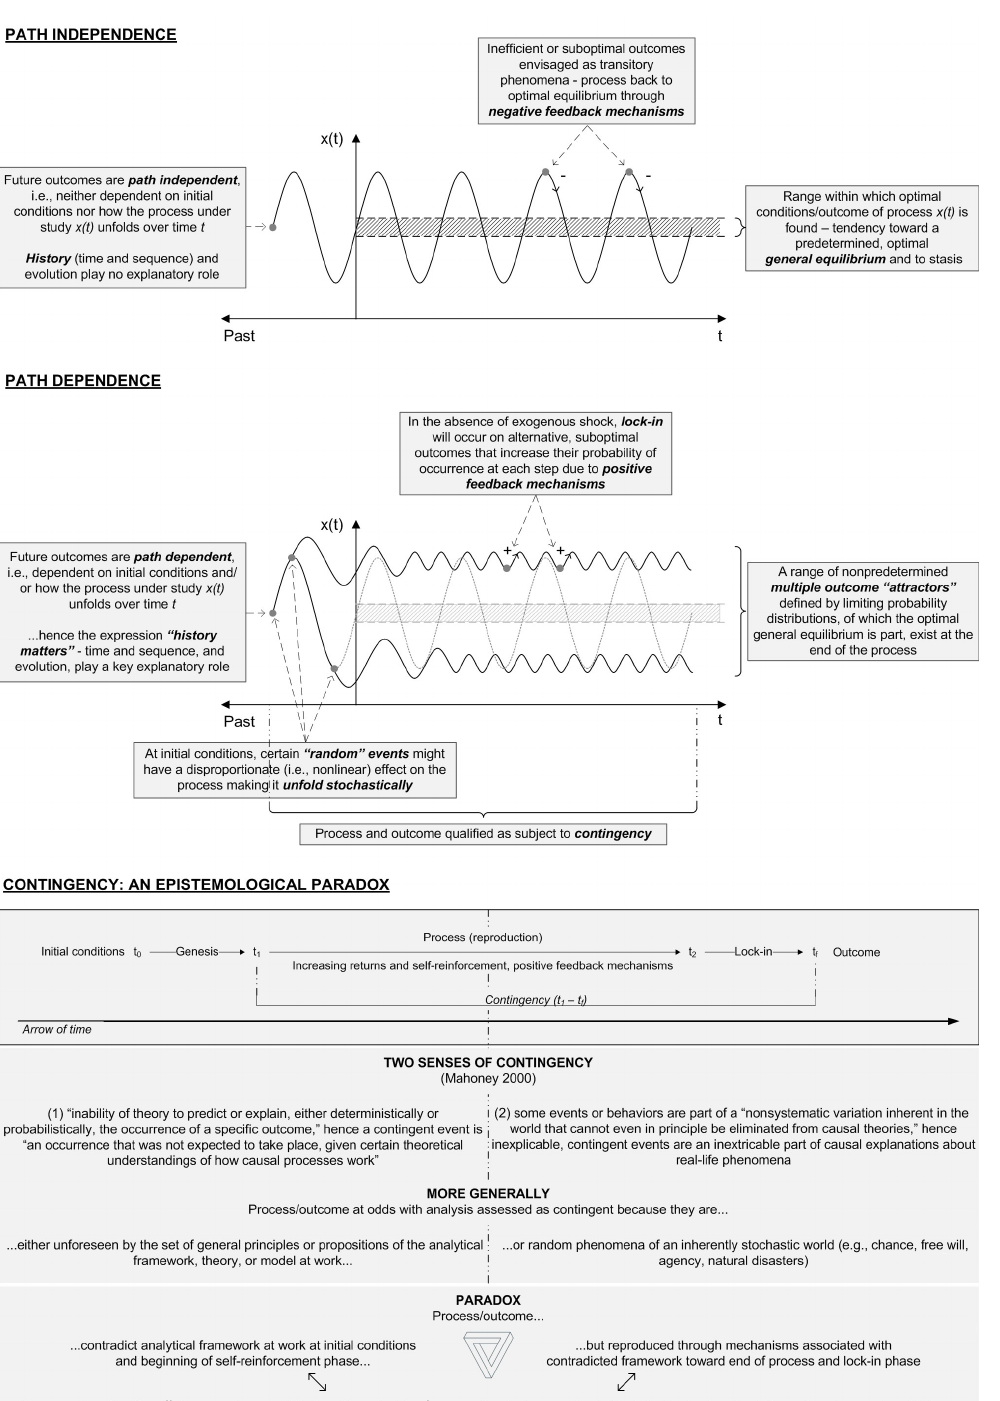
Fig. 4 . Graphical idealization of the concept of path dependence and the epistemological paradox created by the notion of contingency at its core (based on Mahoney 2000), departing from the concept of path independence. For simplification purposes, process/outcome dynamics have been depicted using